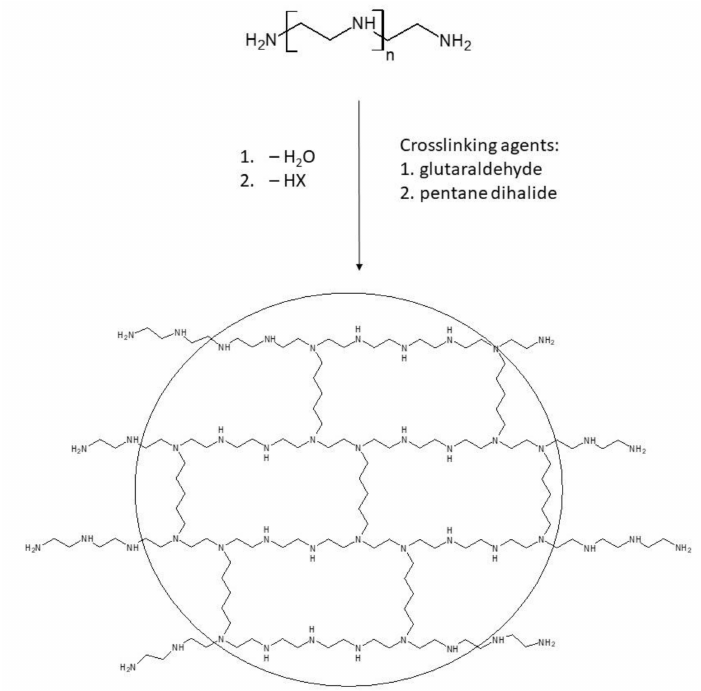
Figure 2. Formation of crosslinked polyethylenimine (PEI) nanoparticles. Adapted from [60]. It is recommended to use a crosslinker in amounts from 1 to 20 mol.% [82]. The crosslink